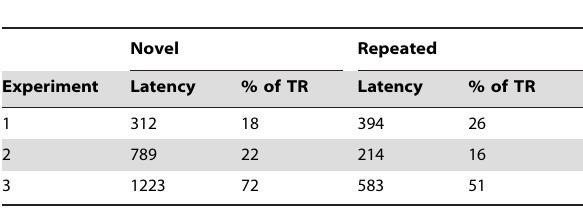
Table 2. Search latencies after contextual cueing and